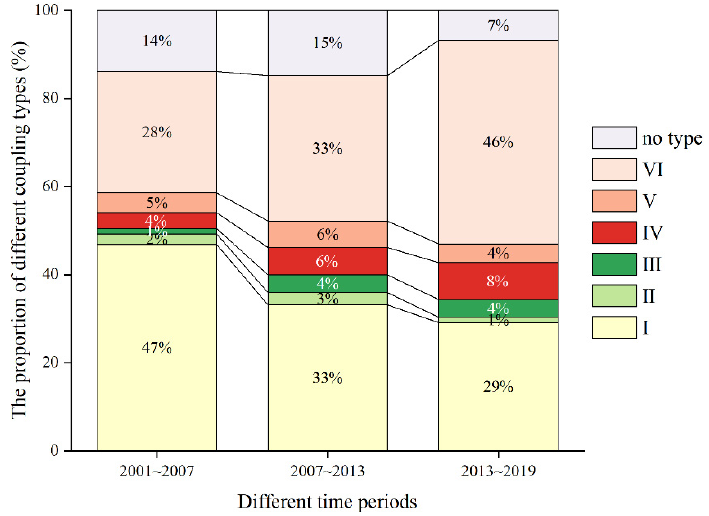
Figure 12. The proportion of different coupling types in different periods.